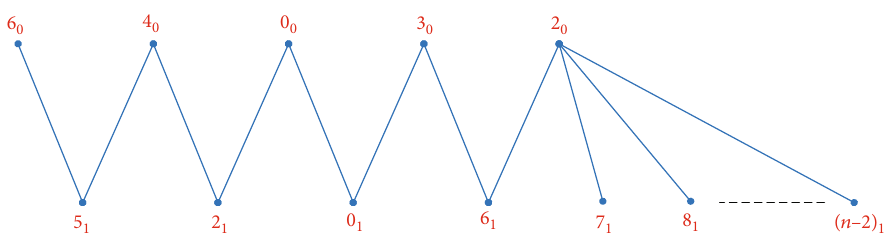
Figure 21: An orthogonal labeling for C